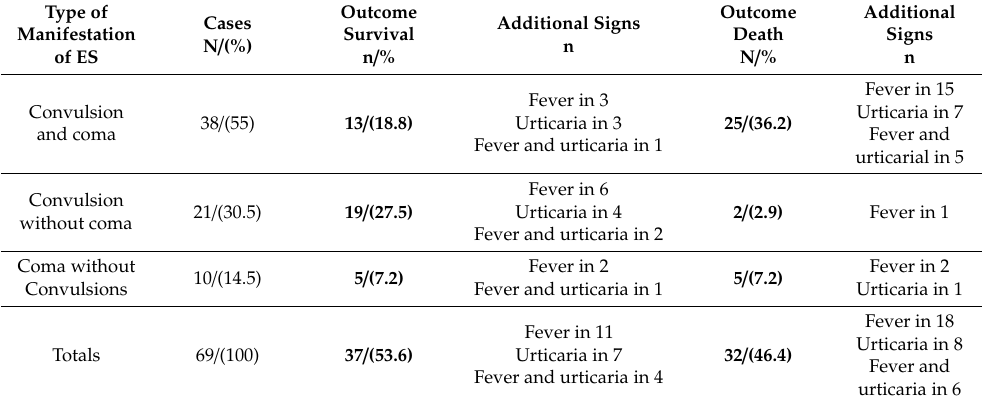
Table 2. Type of manifestation of ES observed and discriminated according to the outcome. The existence of fever and / or maculopapular cutaneous eruption (urticaria) is also